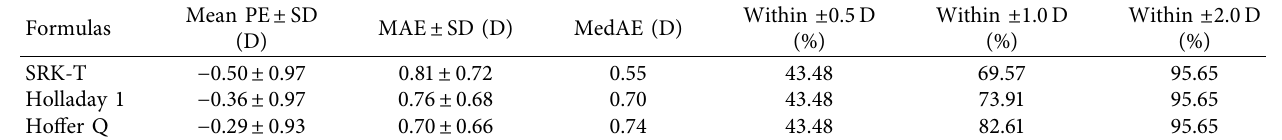
Table 4: IOL power calculation accuracy of 3 IOL